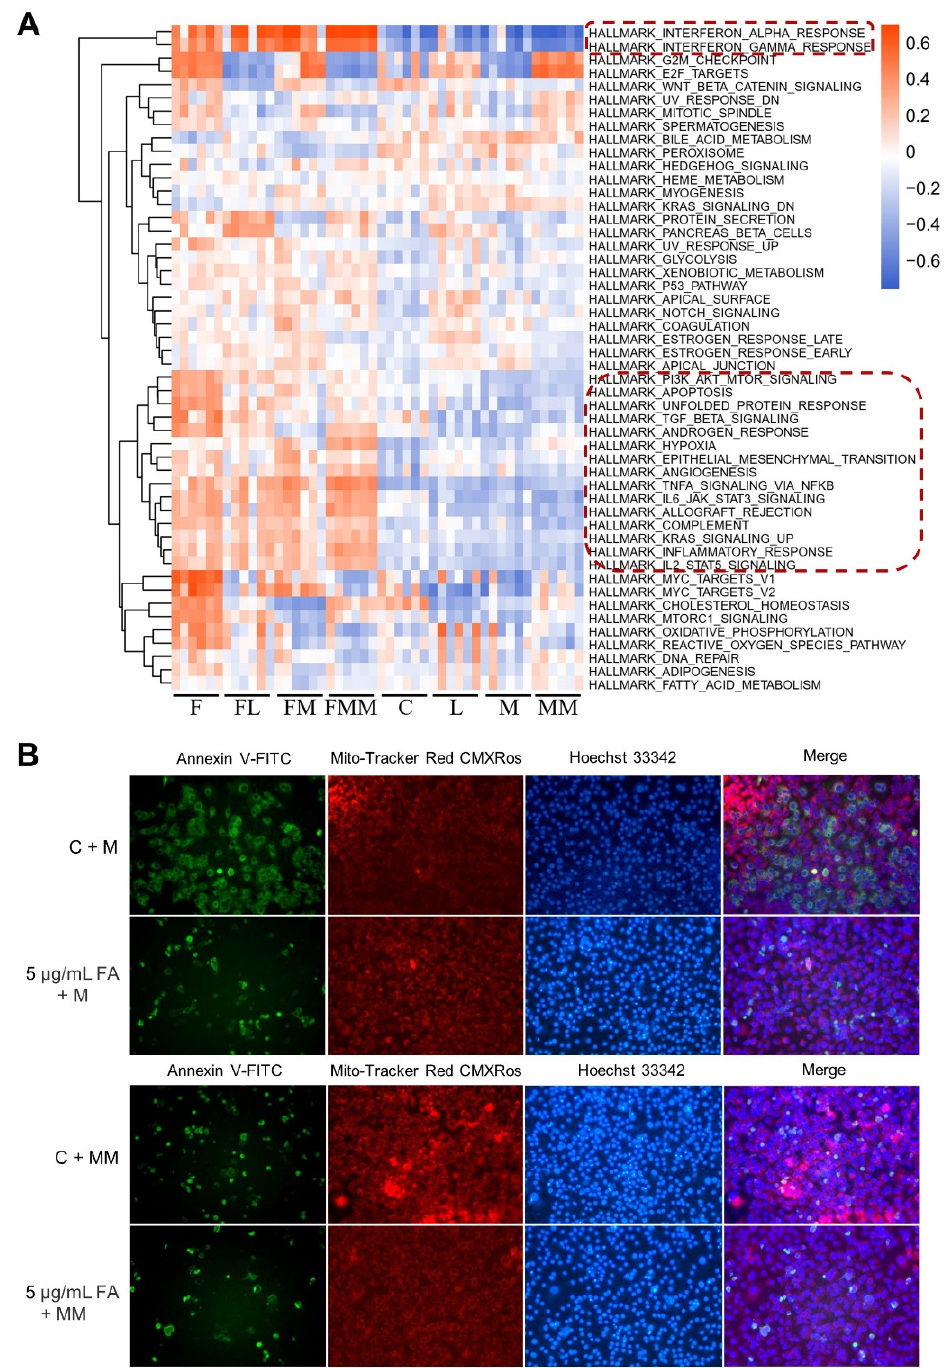
Figure 3. The immune response and apoptosis detection of Mac-T cells after FA treatment and/or S. aureus challenge. ( A ) Heatmap of eight groups in hallmark gene sets by GSVA analysis. The dotted red boxes highlight the immunity-related gene sets. ( B ) FA of 5 µ g/mL can reduce the apoptosis induced by S. aureus challenge in mitochondrial membrane potential and apoptosis detection. Apop- totic cells were strained green by Annexin V-FITC; Cells were strained red by Mito-Tracker Red CMXRos; Cell nucleus were strained blue by Hoechst